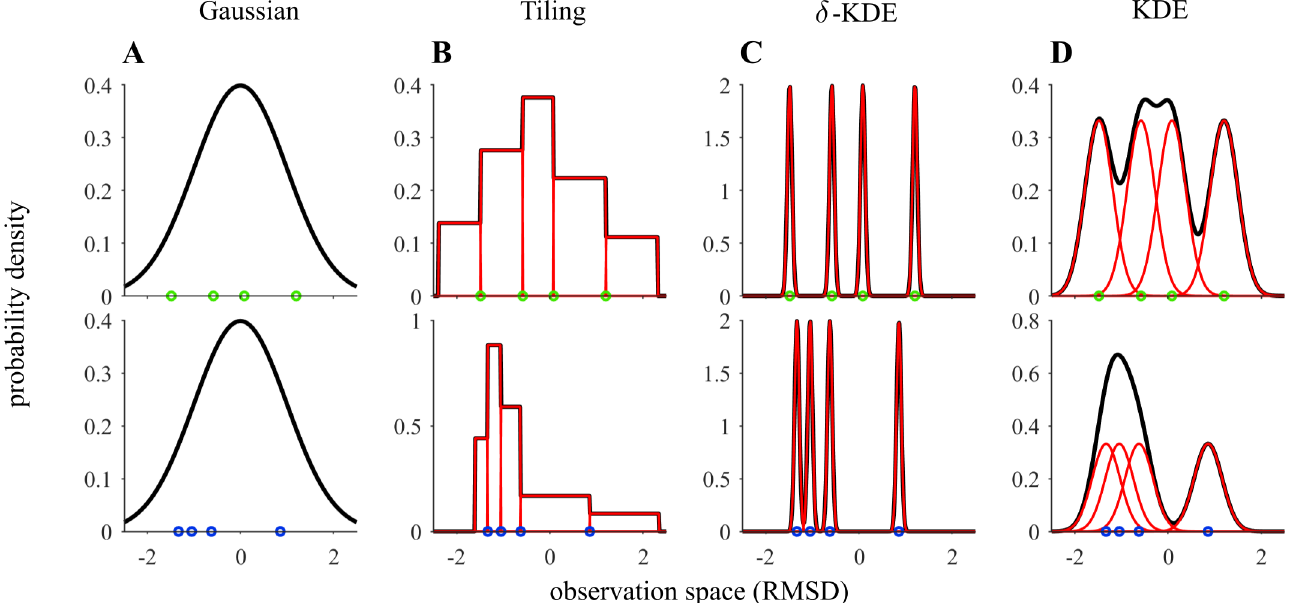
Fig 2. Generalization beyond the observed sample is governed by the parametric assumptions of the distribution. Each row shows examples of probability densities (black lines) for a different sample (green and blue dots, four observations) in units of its root mean squared deviation (RMSD). (A) A zero-centered unimodal Gaussian distribution is used to account for the whole sample. All point positions d = ( d 1 , ... , d 4 ) enter via the estimated standard deviation parameter, σ ML ( d ) (RMSD), determined by probabilistic inference. Whereas for instanced-based generalization the sample points effectively enter as parameters themselves. (B-D) Different additive basis distributions (red) can be used to cover the observation space. The tiling model covers the space with adjacent non-overlapping uniform basis distributions resulting in a compressed distribution around spatially proximal points (B) . Additionally, models can be constructed from simpler components by centering a Gaussian kernel on each observation (see Methods). In the limit of vanishing kernel widths (C) there is no generalization beyond the sample while for larger widths (D) a smoothed density over the whole domain is obtain due to overlapping basis